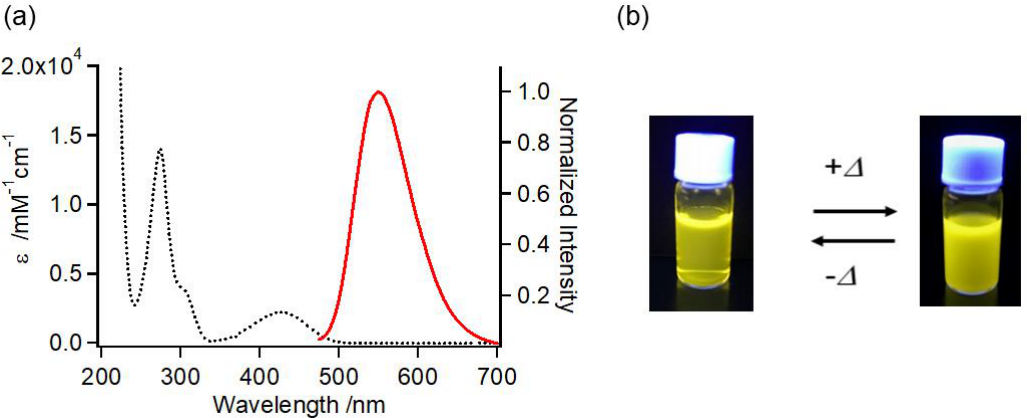
Figure 4. Physical properties of TFMAQ-diEg4. ( a ) The absorption (black dotted line; left axis) and normalized fluorescence (solid red line; right axis) spectra of 20 μM TFMAQ-diEg4, in water. Fluorescence spectrum was obtained using an excitation wavelength of 430 nm. ( b ) Representative image of vials containing 5.0 mM TFMAQ-diEg4 aqueous solution under irradiation, at 365 nm.